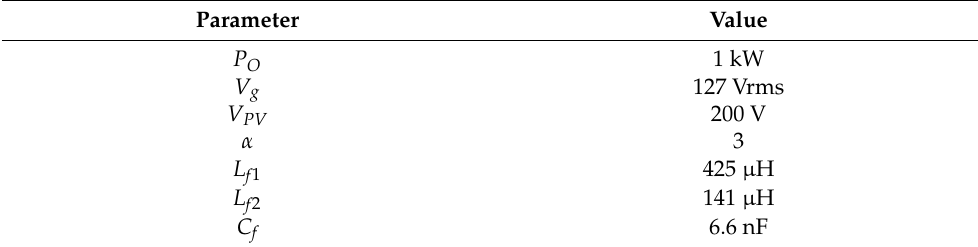
Figure 6. Active power injection filter with LCL filter. From top to bottom: average voltage (100 V/div) and average current (10 A/div). Table 3. Design